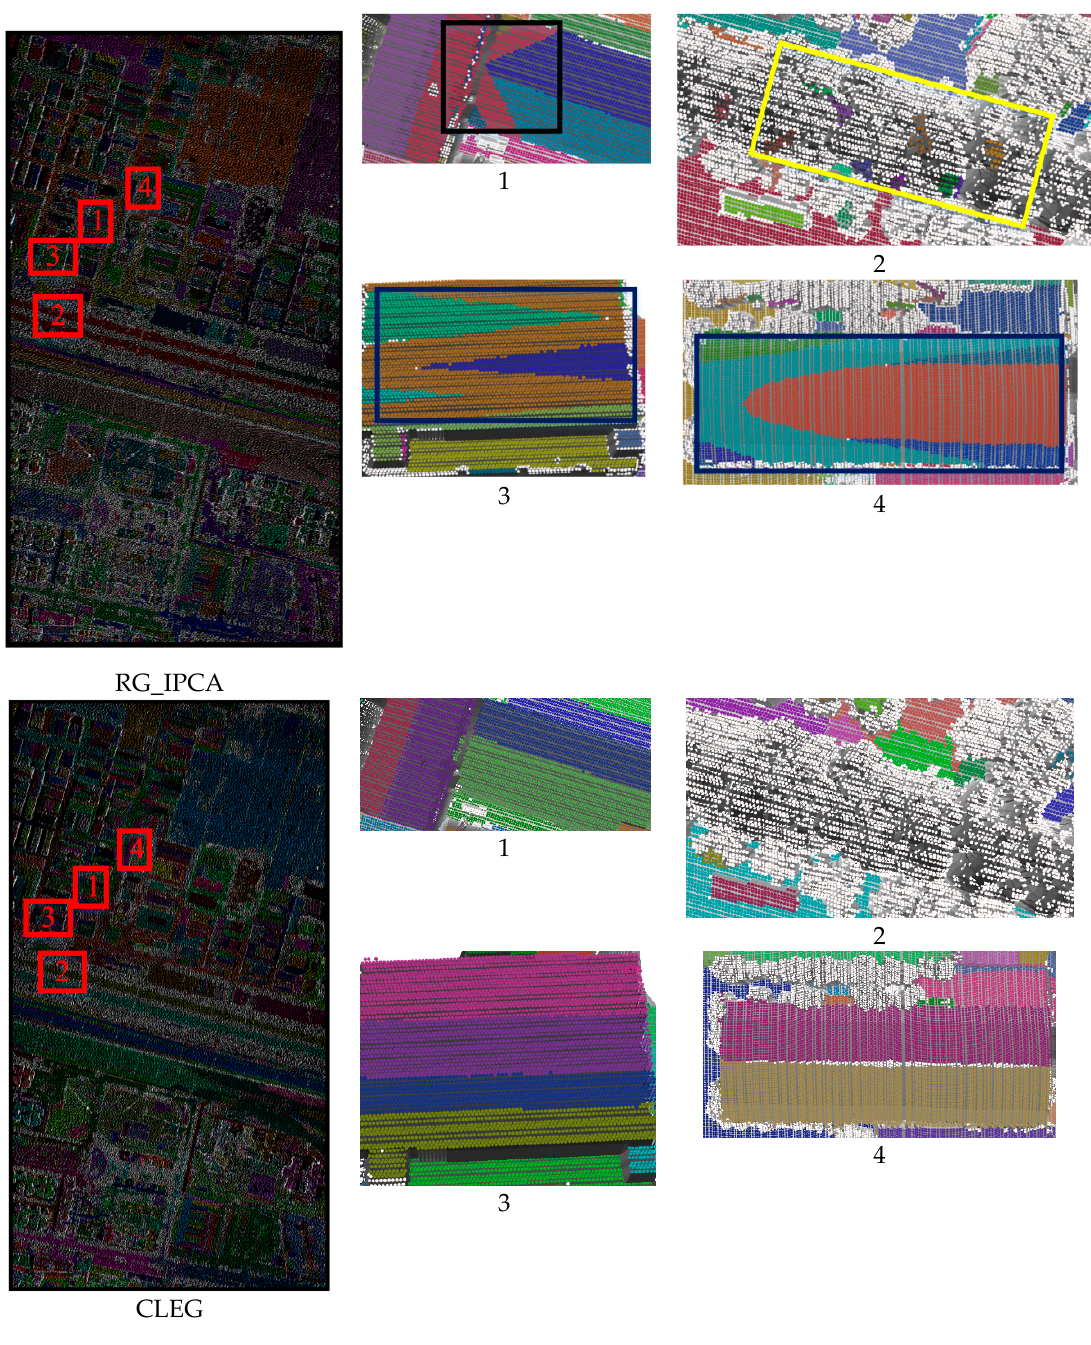
Figure 17. Segmentation results in the Guangzhou area using dataset (f).